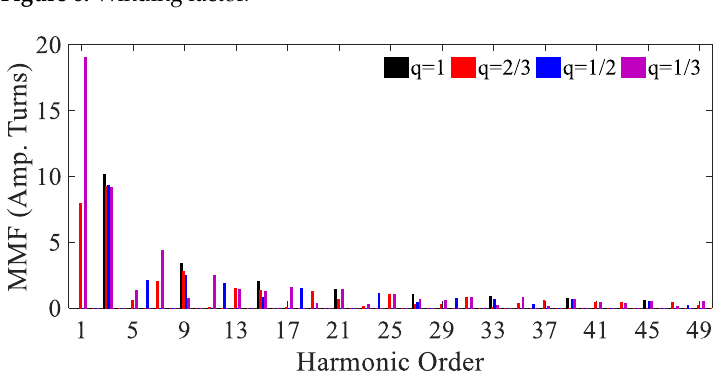
Figure 7. Winding harmonics.